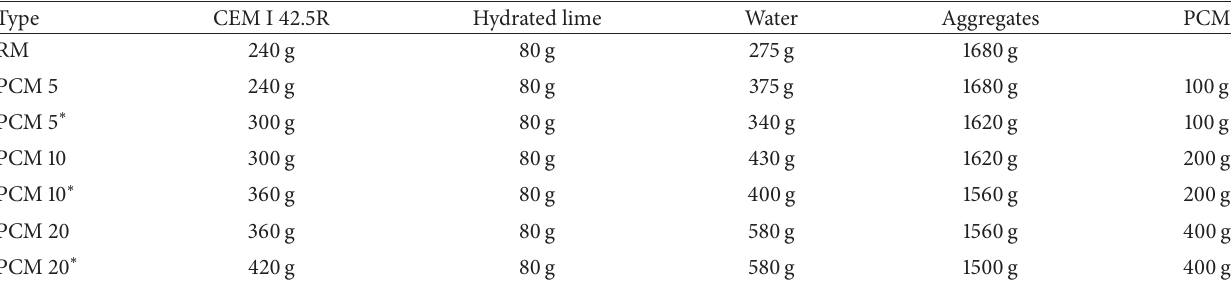
Table 1: Mix design.